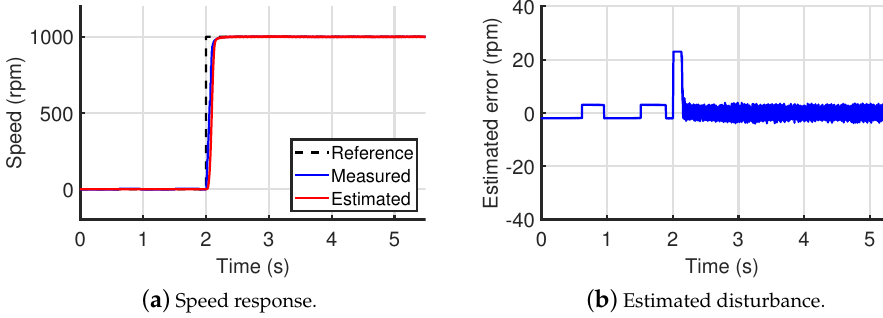
Figure 15. Experimental results of the proposed observer at 1000 rpm.